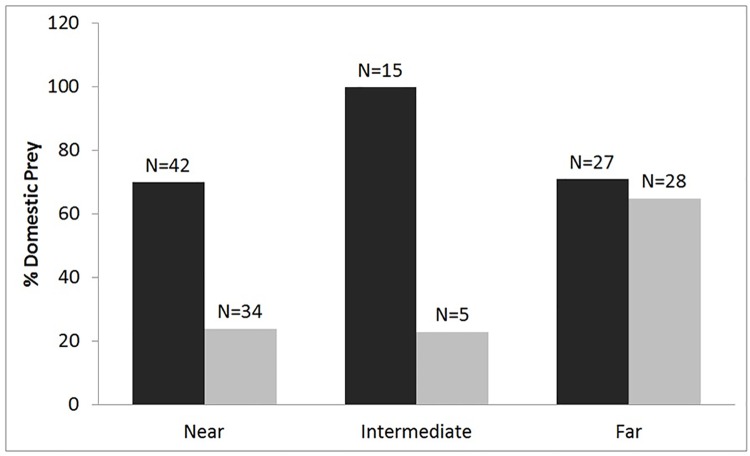
Percentage of domestic animals killed by male (black bars) and female (grey bars) tigers increased with distance from the core zone of PTR.At >10 km distance from the core zone, males and females killed domestic animals in similar proportions, with this result being statistically significant (df = 2, p = < 0.001).